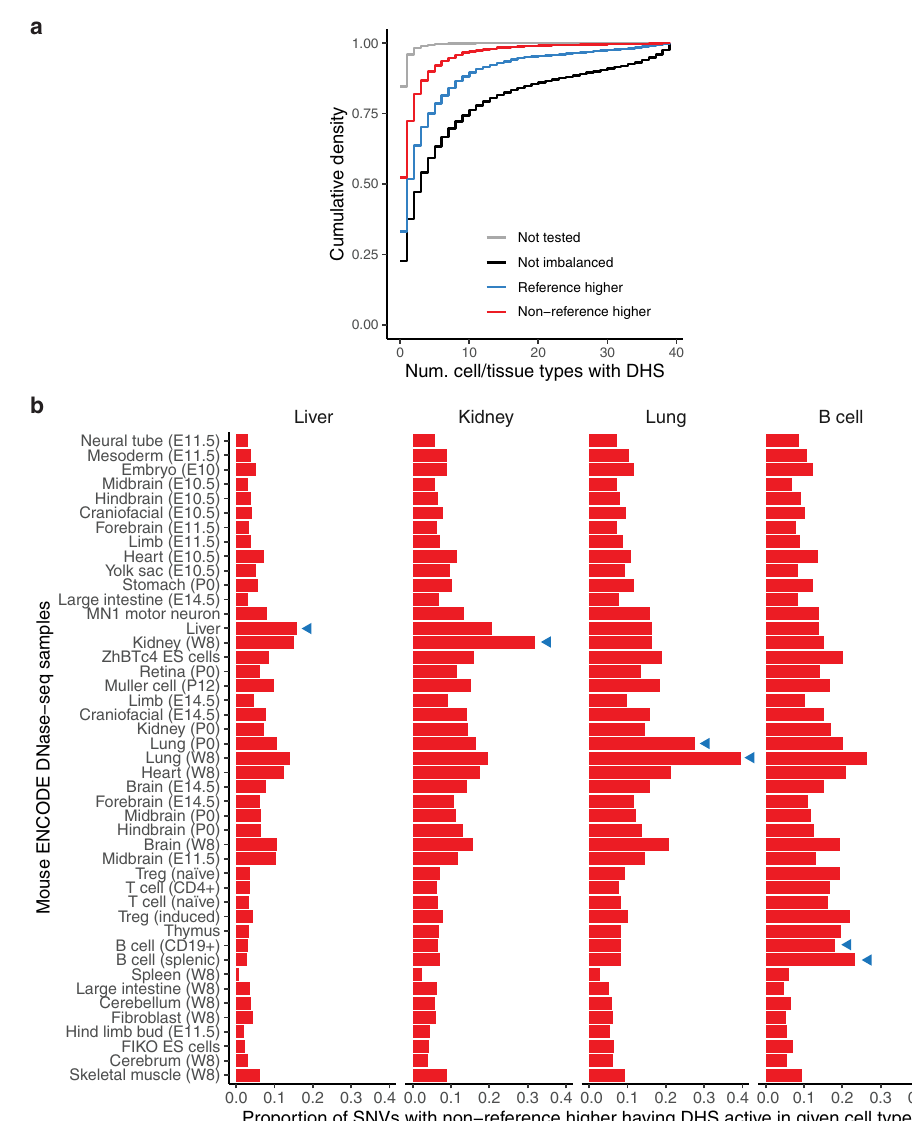
Fig. 2 Predetermination of sites of strain-speci fi c DNA accessibility. a Cumulative density distribution of cell-type activity of DHSs measured across 39 mice ENCODE DNase-seq samples in reference C57BL/6 mice 24 . DHSs are strati fi ed based on whether imbalance favored the reference or non-reference allele. Not tested refers to the set of mappable SNVs not in DHSs for Liver, Kidney, Lung, or B cells and therefore not tested for imbalance. b The proportion of imbalanced SNVs from a given cell/tissue type that overlap DHSs from mouse ENCODE cell and tissue types (along the y -axis). Cell and tissue types are ordered based on the hierarchical clustering of all hotspots. Developmental time points for some samples are indicated in parenthesis (E, embryonic day; P, postpartum, W; adult week). Blue triangles indicate ENCODE samples matching tissues from hybrid mice in this study.